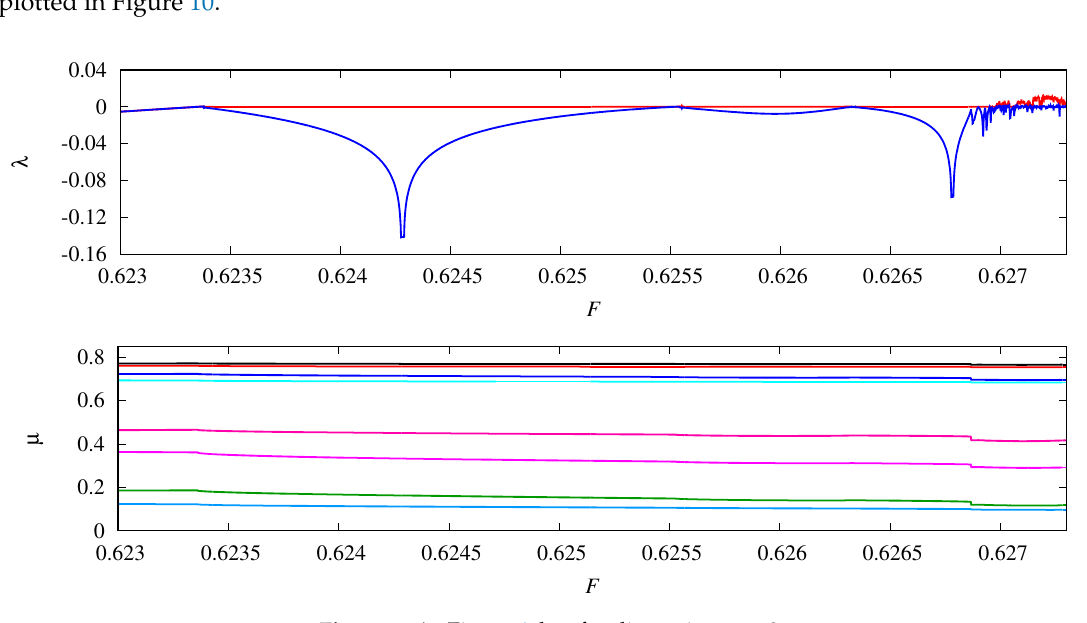
Figure 9. As Figure 4, but for dimension n =